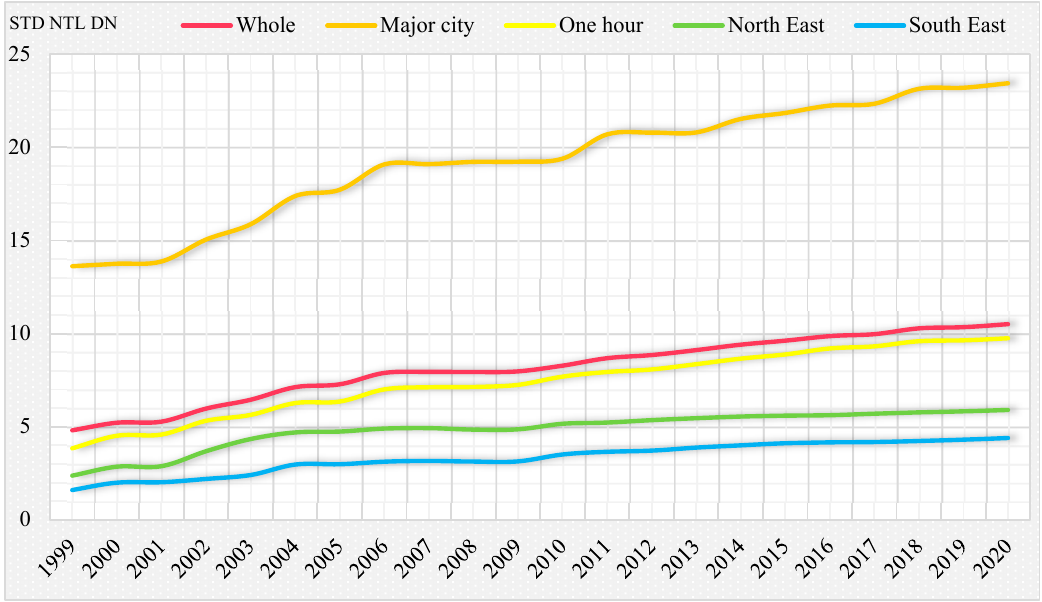
Figure 13. NTL standard from 1999 to 2020 for Chongqing and four sub-city regions.